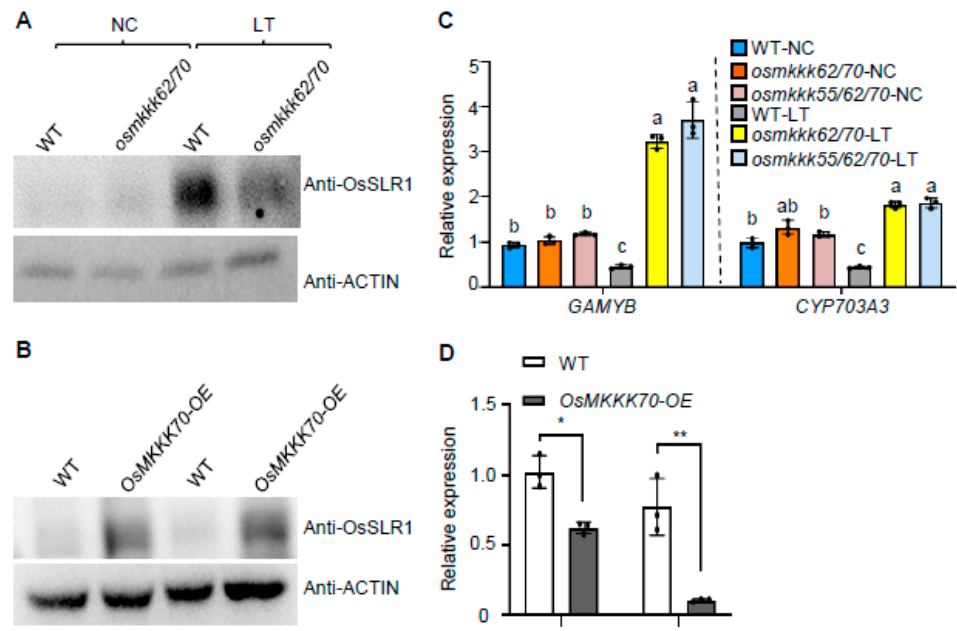
Figure 5. OsMKKK70 negatively regulates CTB by modulating the GA content in anthers. ( A ) OsSLR1 protein level in anthers of WT and osmkkk62/70 plants grown under NC and after LT treatment for 4 days detected by anti-OsSLR1 antibody. ACTIN contents detected with anti-ACTIN antibody were used as loading control. ( B ) OsSLR1 protein level in anthers of WT and OsMKKK70-OE plants grown under NC detected by anti-OsSLR1 antibody. ACTIN contents detected with anti-ACTIN antibody were used as loading control. ( C ) The expression of GAMYB and CYP703A3 in anthers of WT, osmkkk62/70, and osmkkk55/62/70 plants grown under NC and after LT treatment for 4 days. Each dot represents the result from one biological replicate; error bars indicate means ± SE (n = 3). Statistically significant differences are indicated by different lowercase letters ( p < 0.05, one-way ANOVA with Tukey’s significant difference test). ( D ) The expression of GAMYB and CYP703A3 in anthers of WT and OsMKKK70-OE plants grown under NC. Each dot represents the result from one biological replicate; error bars indicate means ± SE (n = 3). p values were calculated by Student’s t -test. ** p < 0.01; * p < 0.05.